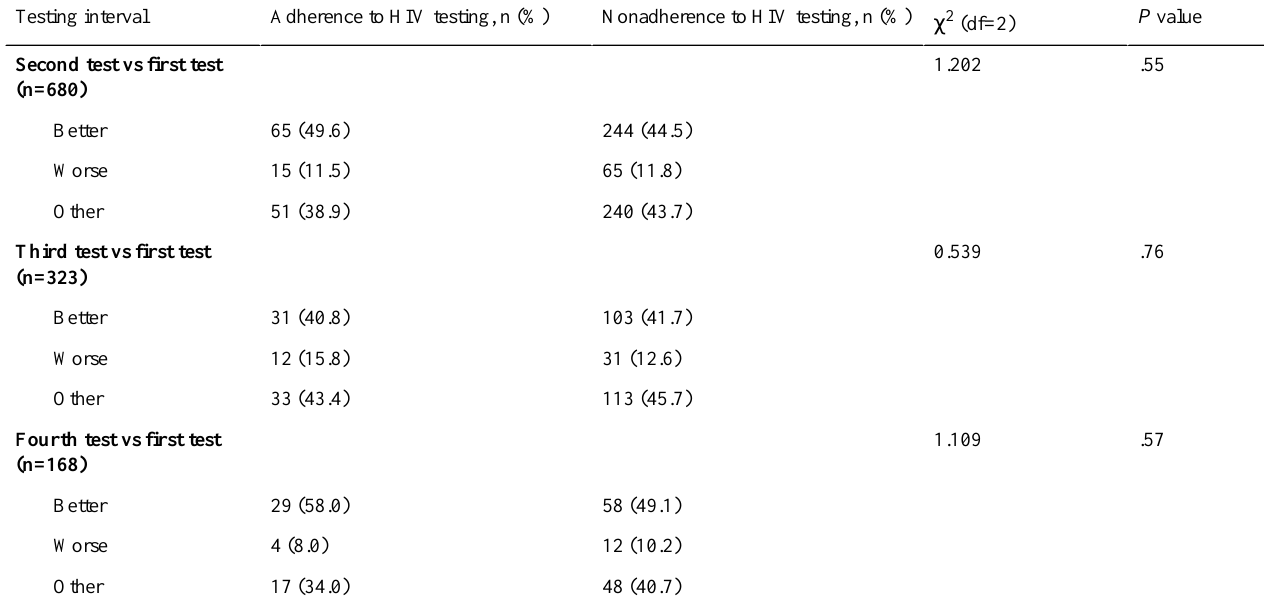
Table 5. Comparison of condom use behavior changes in the adherence and nonadherence